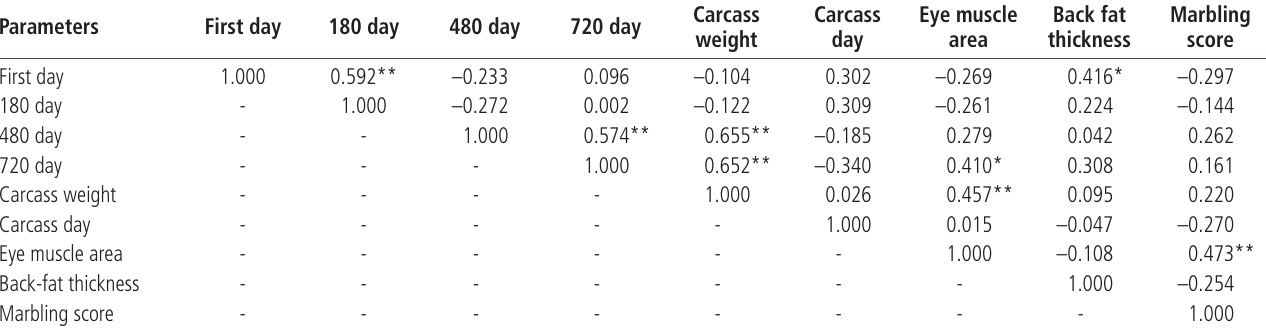
Table 3. Correlation analysis of growth pattern and carcass characteristics of the greatest meat yield group Parameters